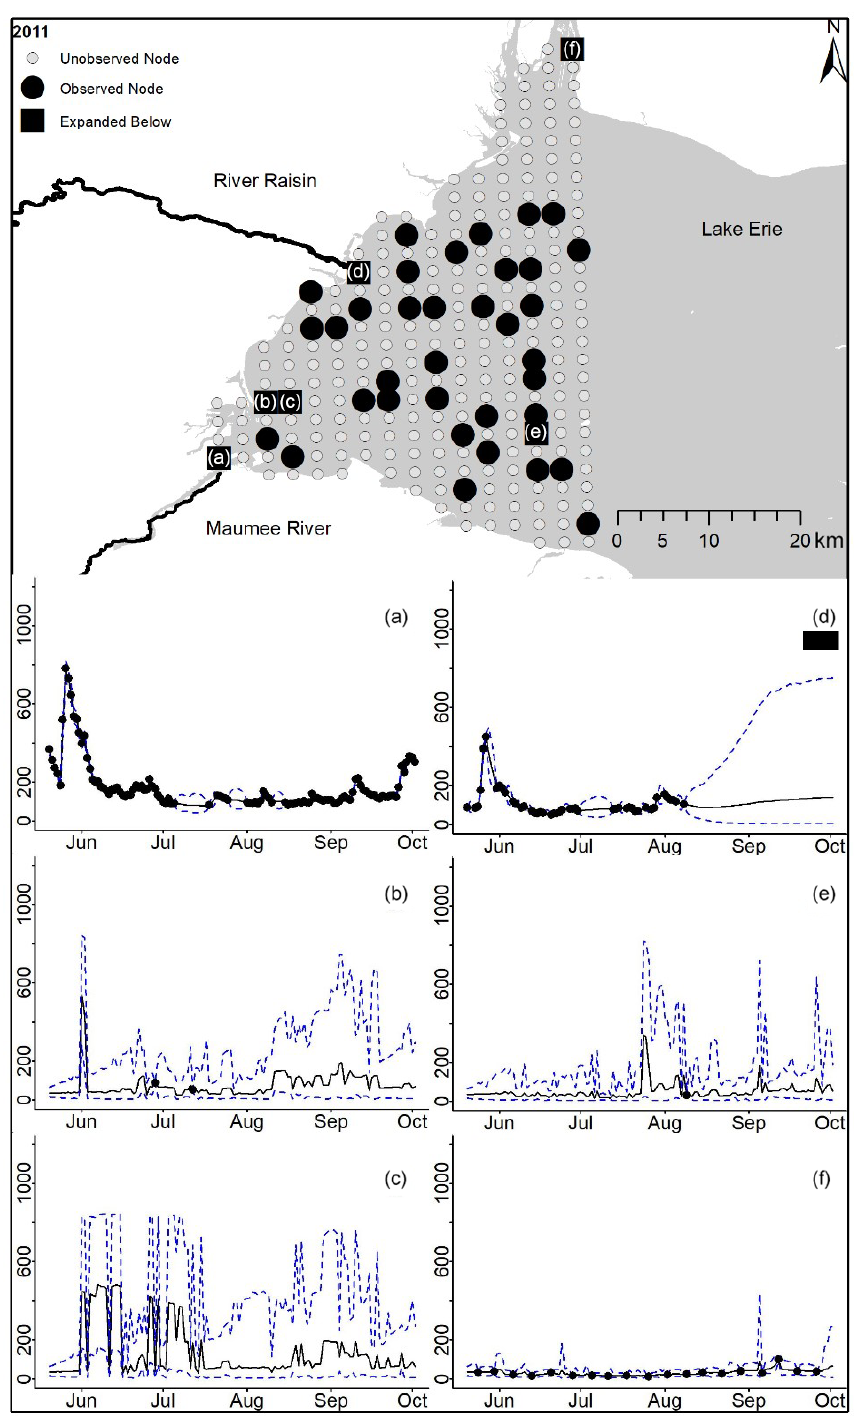
Figure D4. For 2011 the total phosphorus concentrations (µgL − 1 ) at observed and unobserved nodes were estimated from the model posterior samples. Mean (solid black line) and 95%PI (dashed blue line) for the model posterior samples of each node at every day for (a) the Maumee River, (b, c, e, f) western Lake Erie nodes, and (d) the Raisin